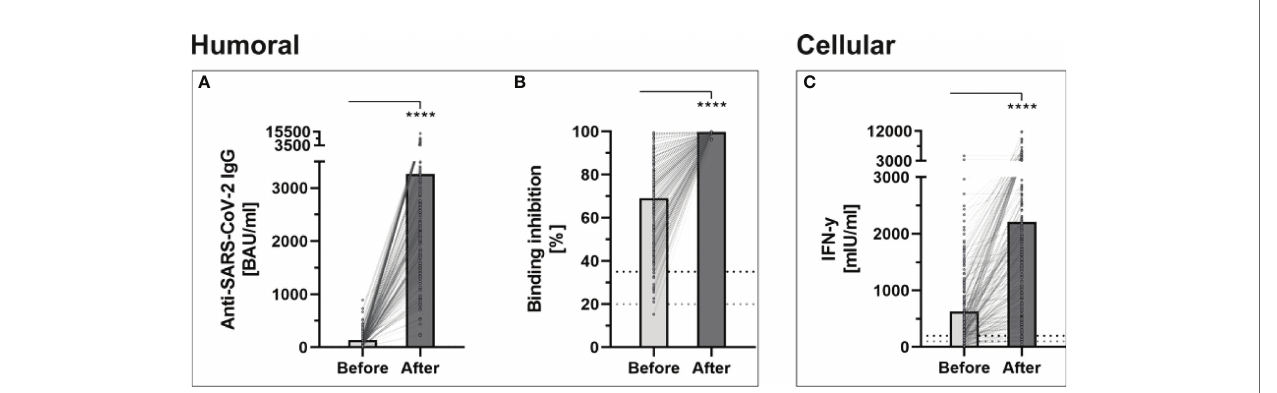
FIGURE 1 | Determination of humoral- and cellular immunity against-SARS-CoV-2 before and four weeks after third booster vaccination with BNT162b2 (n = 243). (A) Anti- SARS-CoV-2-IgG binding antibodies were determined using a quantitative assay from Abbott. In keeping with the WHO-standard, data were expressed in Binding Antibody Units per ml (BAU/ml). Samples were marked seronegative below 7.1 BAU/ml whereas values above 7.1 BAU/ml were determined to be positive, as mentioned by the manufacturer. (B) Binding inhibition capability of Neutralizing anti-SARS-CoV-2 antibodies was determined using the NeutraLISA ™ SARS-CoV-2 Neutralization Antibody Detection KIT from Euroimmun. According to the manufacturer, binding inhibition values above 35% were considered positive (horizontal black dotted line), whereas values between 20% and 35% were considered equivocal (horizontal gray dotted line). (C) Cellular immunity to SARS-CoV-2 was assessed by using an Interferon (IFN)-gamma release assay (IGRA) from Euroimmun (Quan-T-cell SARS-CoV-2 kit). Values > 200 mIU/ml were considered positive (horizontal black dotted line), whereas values between 100-200 mIU/ml were considered equivocal (horizontal gray dotted line). ****p < 0.0001 (Mann-Whitney